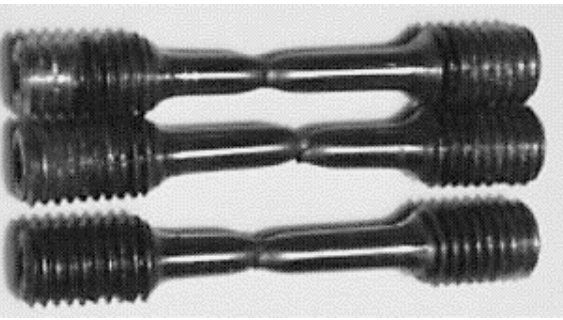
Figure 1. Ruptured samples after the tensile limit test (St12T steel, temp. 400 °C). The experiment is based on the Heckert EUS-20 hydraulic universal testing machine